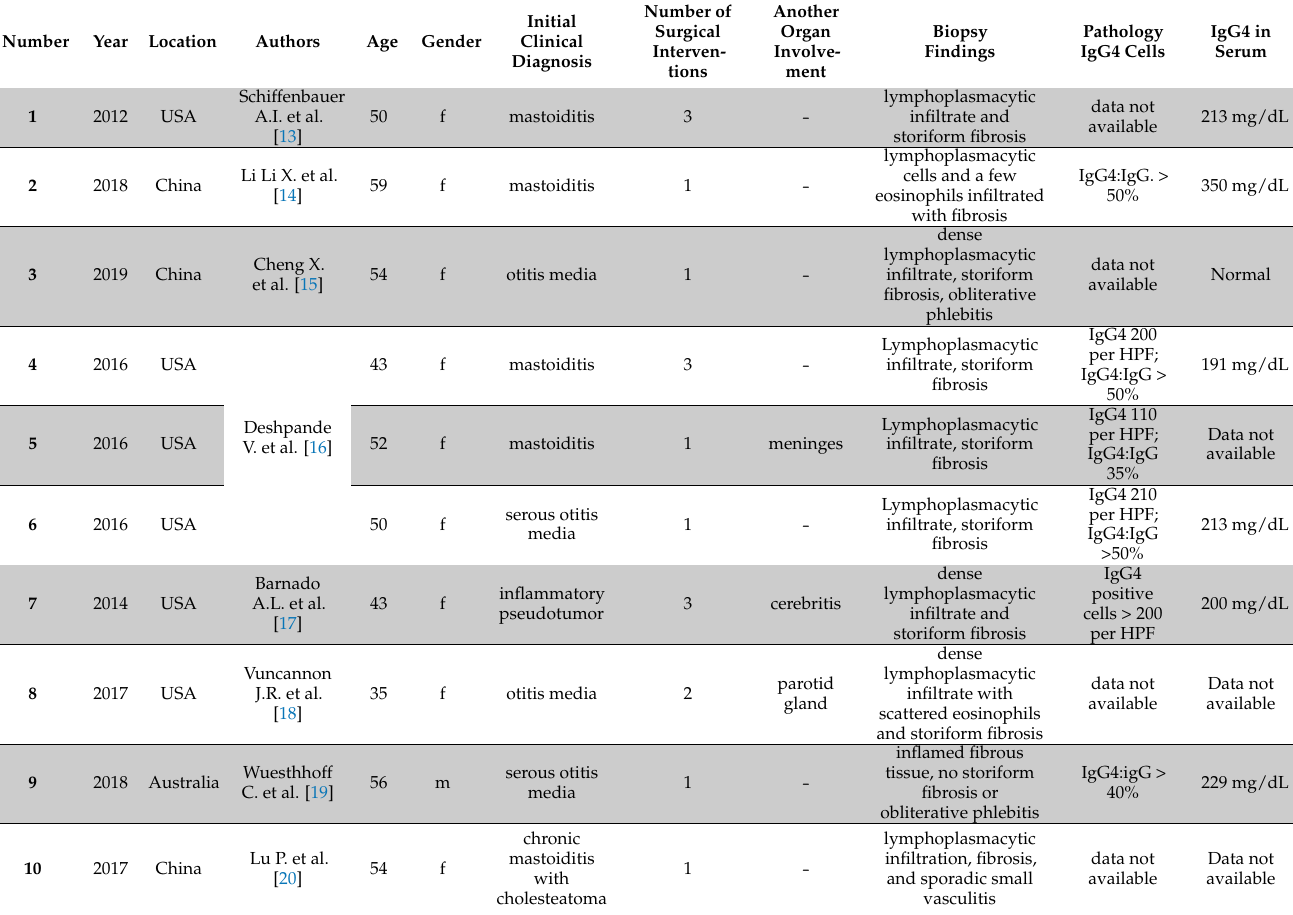
Table 1. IgG4 related disease in the